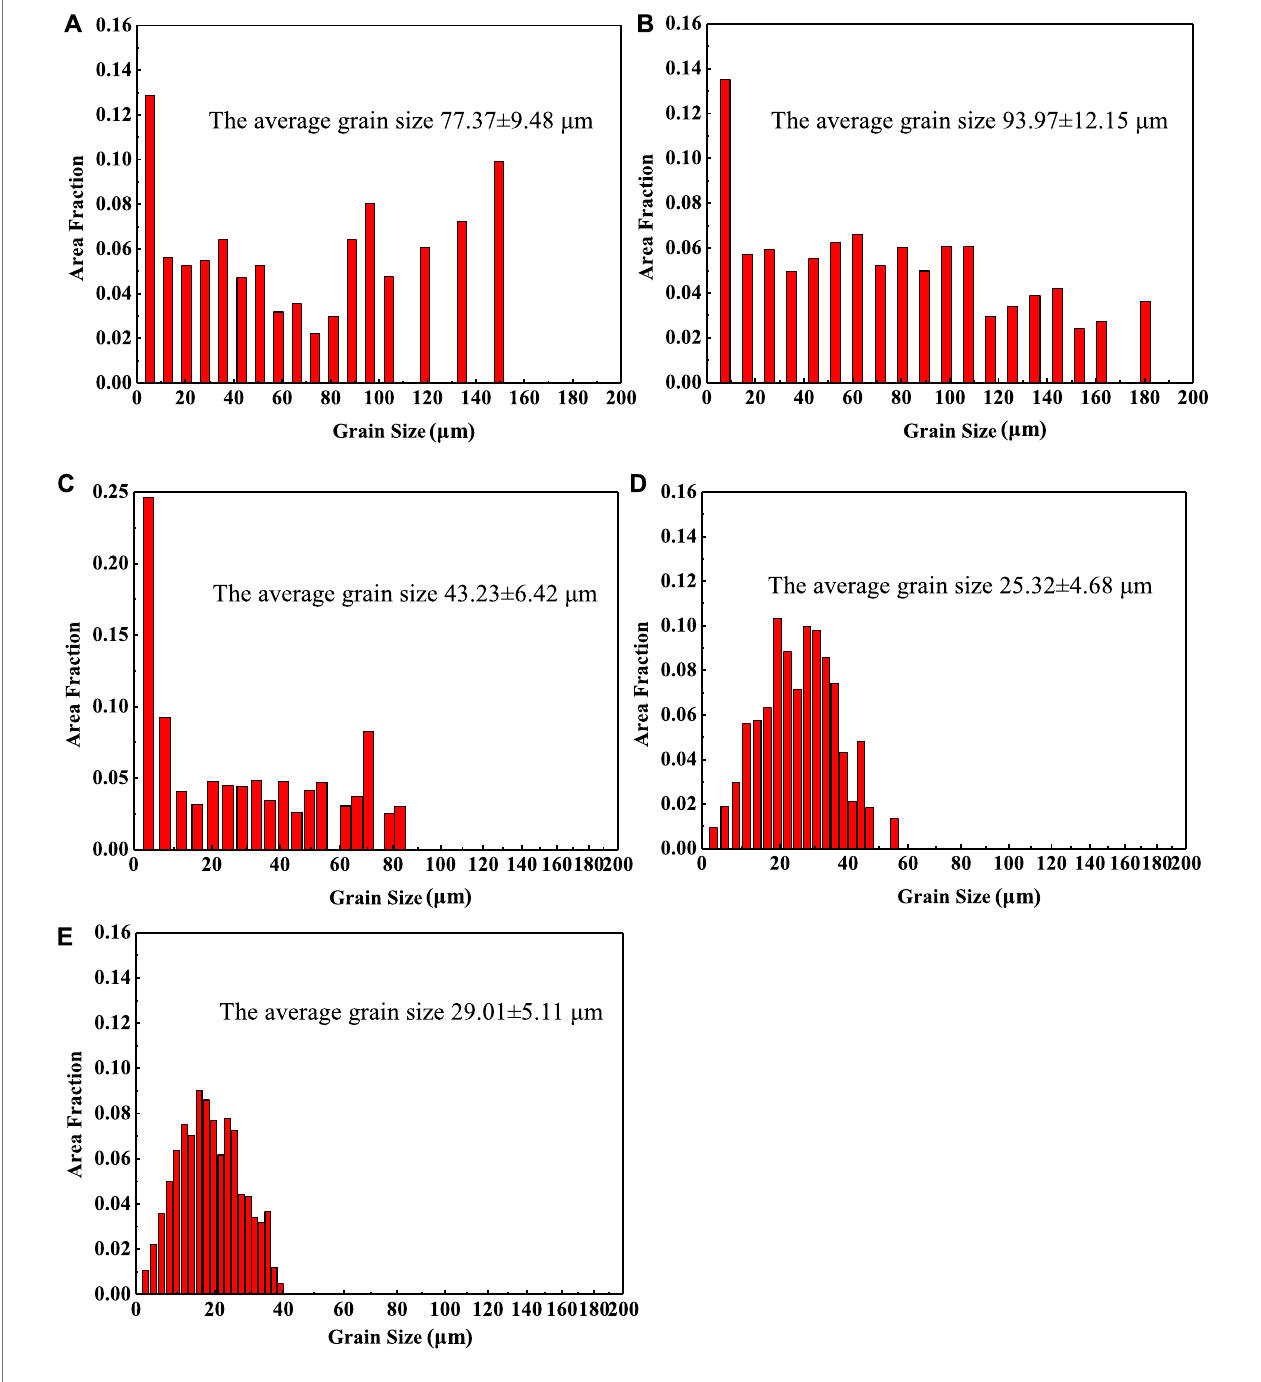
FIGURE 5 | Grain size distributions of the Co – Ni – Cr – W – based superalloy deformed at different temperatures with the strain rate of 0.1 s − 1 : (A) 1,000 ° C, (B) 1,050 ° C, (C) 1,100 ° C, (D) 1,150 ° C, and (E) 1,200 ° C.